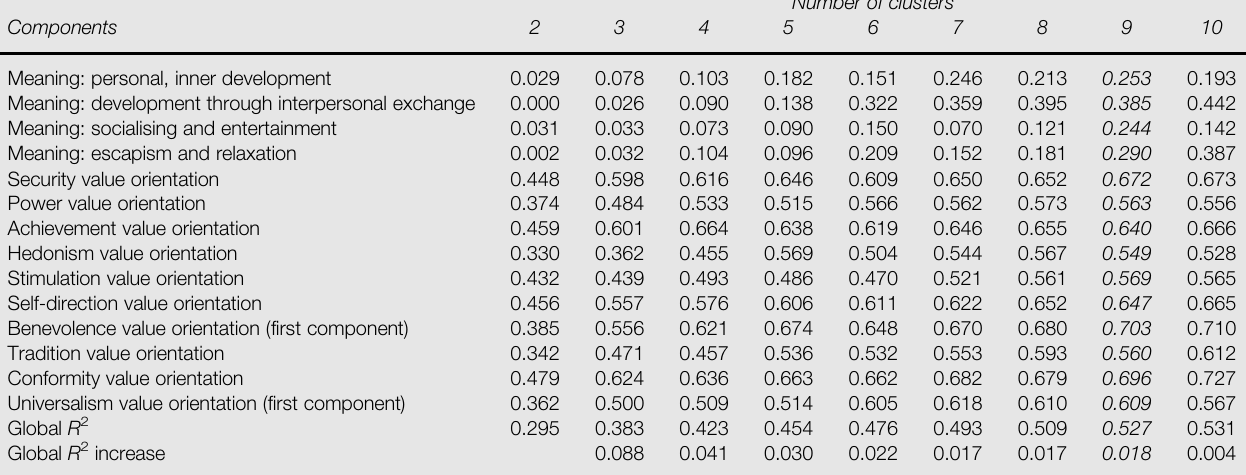
Table IV R 2 for each component (PCA) and R 2 global for the number of partitions solutions processed from sampled data